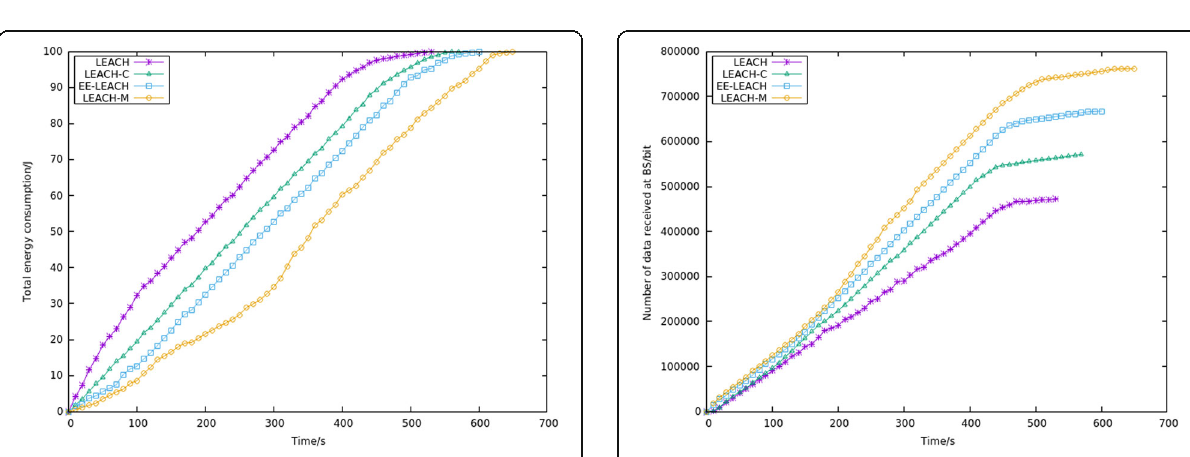
Fig. 5 The comparison of energy usage for LEACH, LEACH-C, EE- LEACH, and LEACH-M in 100 × 100m 2